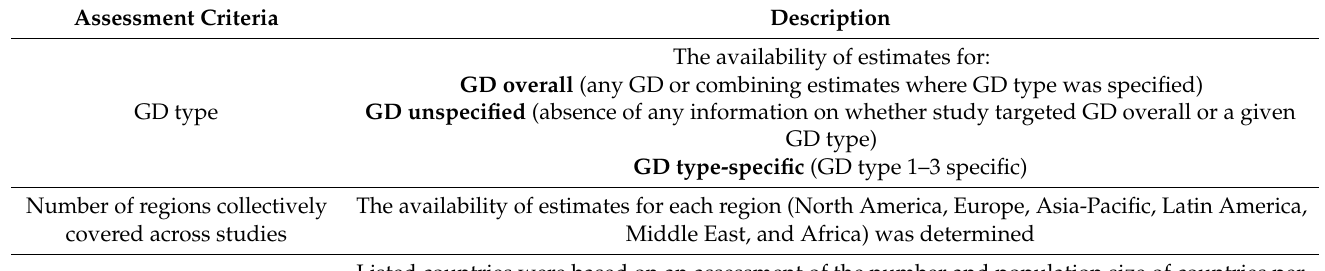
Table 2. Rules to assess regional generalizability of